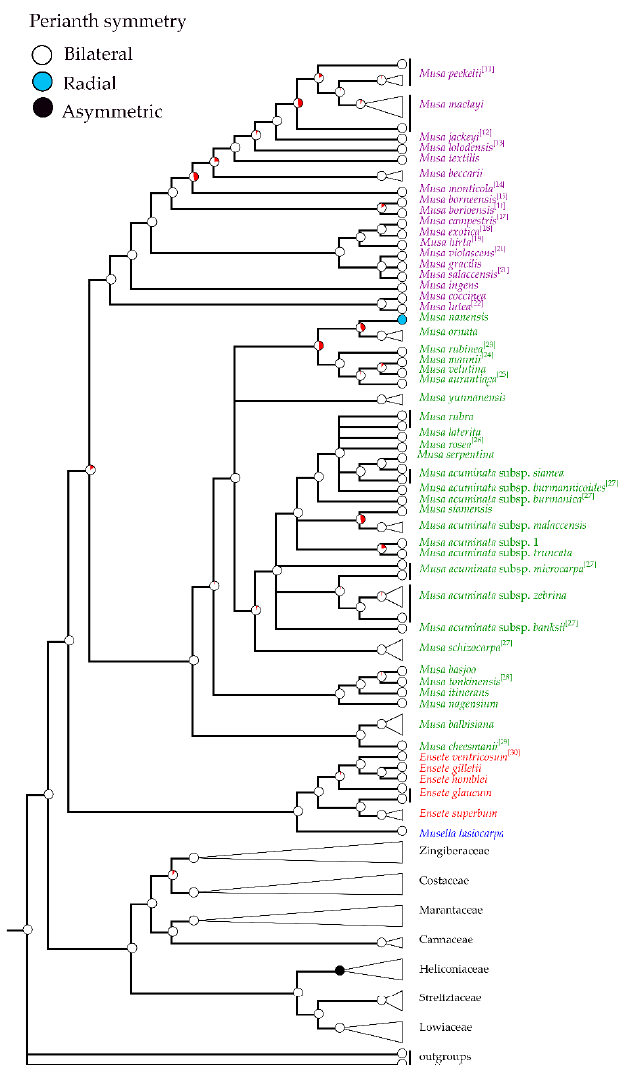
Figure 3. Ancestral state reconstruction, based on Bayesian posterior probabilities of selected mor- phological states on Bayesian topology constructed from nrDNA and plastid combined data. The tree shows the evolution of the perianth symmetry in the order Zingiberales with emphasis on Musaceae. The phylogenetic relationship included the families within Zingiberales (Musaceae, Strelitziaceae, Lowiaceae, Heliconiaceae, Costaceae, Cannaceae, Marantaceae and Zingiberaceae). The tree sepa- rated banana clades including Musella (blue), Ensete (red), species of sect. Musa (green) and species of sect. Callimusa (purple). Circles on nodes show character changes between the taxa, red pie represent node absent. Morphological characters from other publications were labeled with reference number